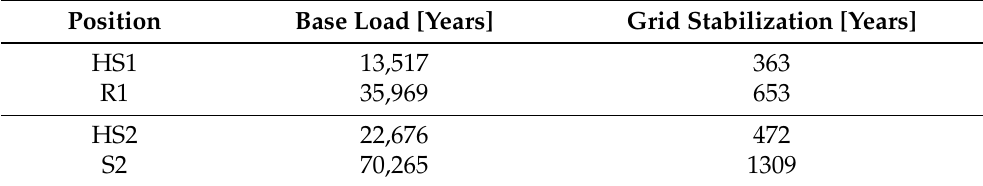
Table 11. Expected lifetime for critical hotspots HS1 and HS2 in years for scenarios base load and grid